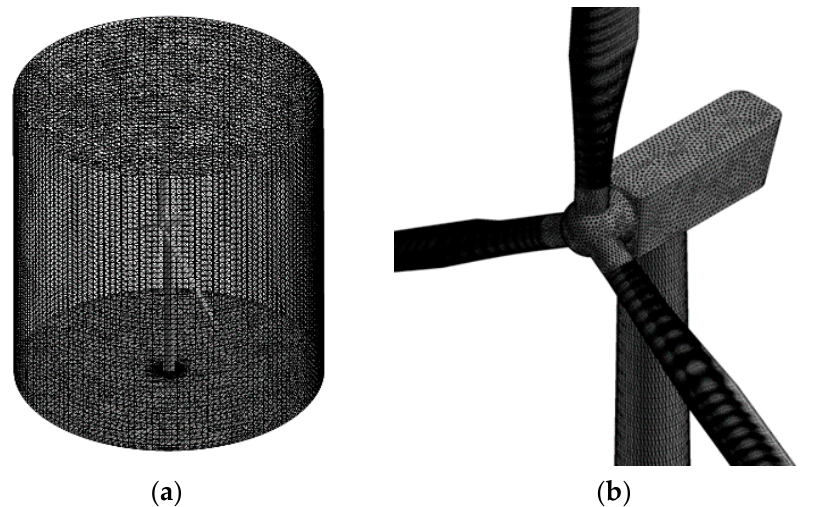
Table 4. Boundary conditions.